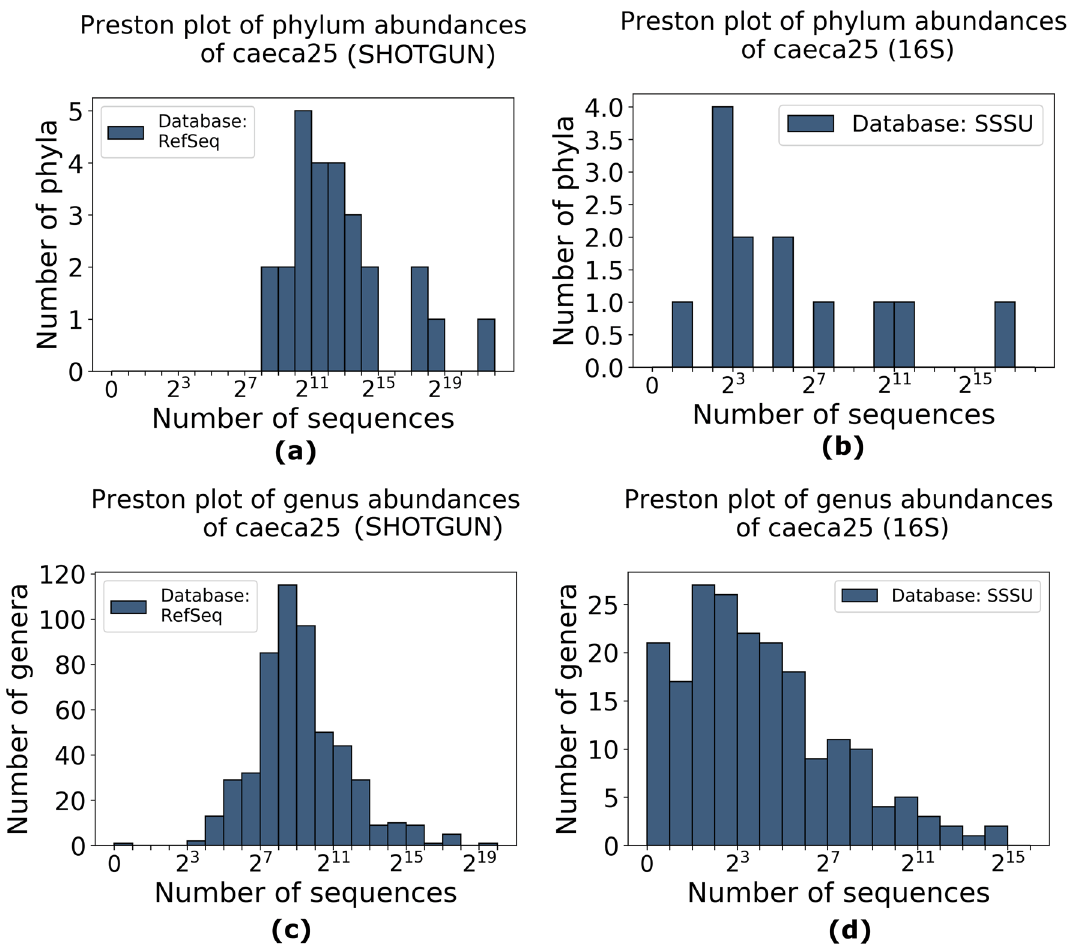
Figure 1. RSA histograms in logarithmic scale (Preston plots 21 ) of bacterial abundances in one sample selected as anexample (caeca25): ( a ) genera sampled by shotgun sequencing, ( b ) genera sampled by 16S rRNA sequencing, ( c ) phyla sampled by shotgun sequencing and ( d ) phyla sampled by 16S